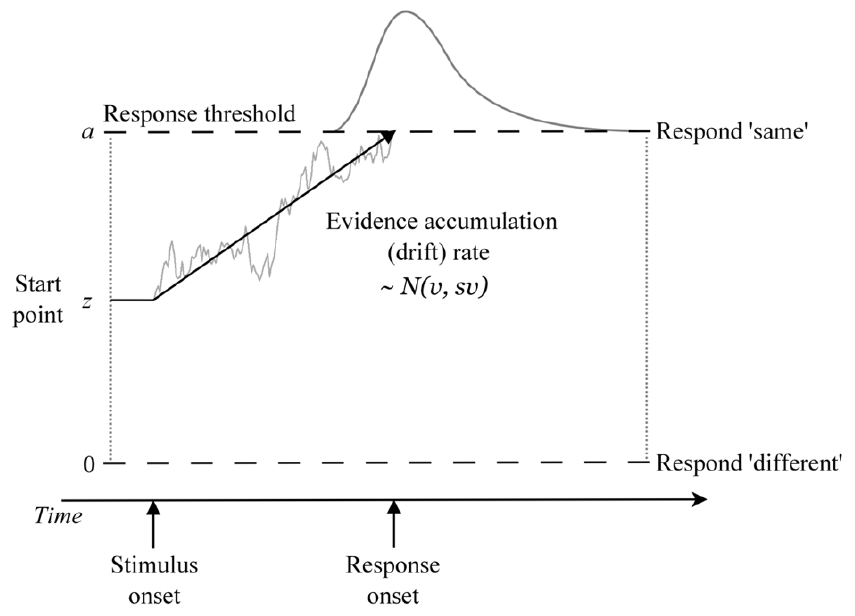
Figure 2. Illustration of the DDM as applied to the reference-back task. Within a trial, the evidence about whether the probe stimulus matches the WM referent is accumulated with mean drift rate v until a response threshold is reached, triggering the corresponding response (at the time labeled ‘response onset’). Response time is the time it takes to reach a threshold (decision time), plus an intercept term representing non ‐ decision time processes that occur outside of the decision stage. The DDM explains effects in terms of model parameters, representing the underlying cognitive processes that give rise to behavior. The most important among these are the drift rate, non ‐ decision time, and threshold parameters.